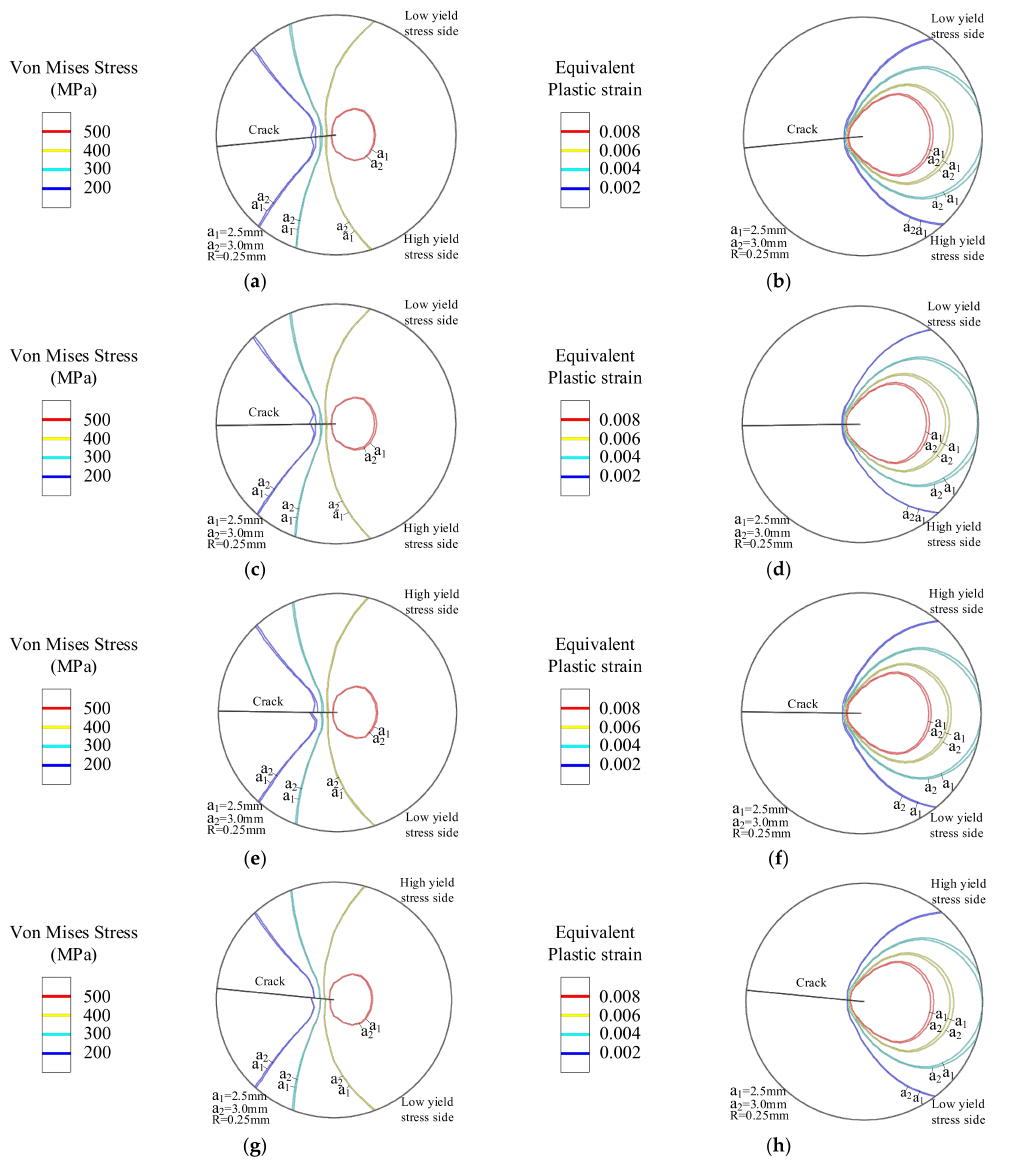
Figure 17. The static crack tip mechanical field with different lengths in the y -direction of the yield strength. ( a ) G y = − 1.0 Von Mises stress and ( b ) Equivalent plastic strain contour. ( c ) G y = − 0.5 Von Mises stress and ( d ) Equivalent plastic strain contour. ( e ) G y = 0.5 Von Mises stress and ( f ) Equivalent plastic strain contour. ( g ) G y = 1.0 Von Mises stress and ( h ) Equivalent plastic strain